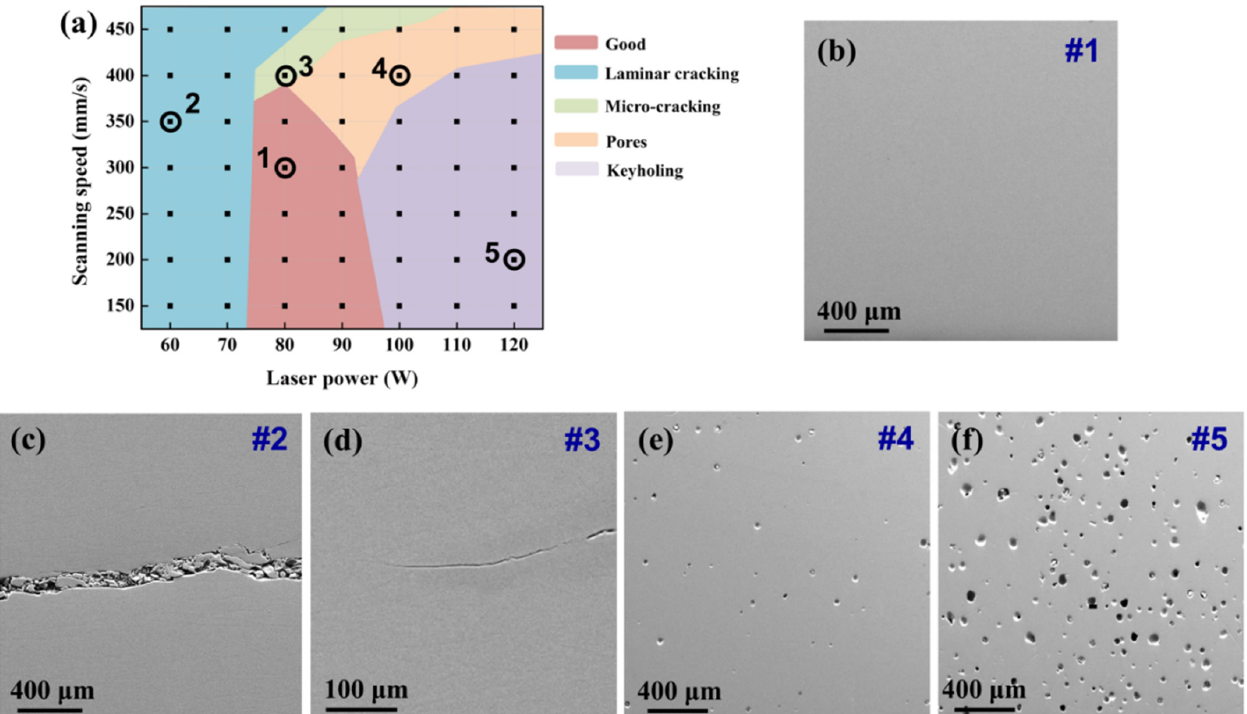
Figure 2. ( a ) Process parameter map of the orthogonal experiment with variable laser power and scanning speed; ( b – f ) SEM images of the polished SLM bulk 60NiTi blocks. Samples #1–#5 correspond to the marked points in ( a ).